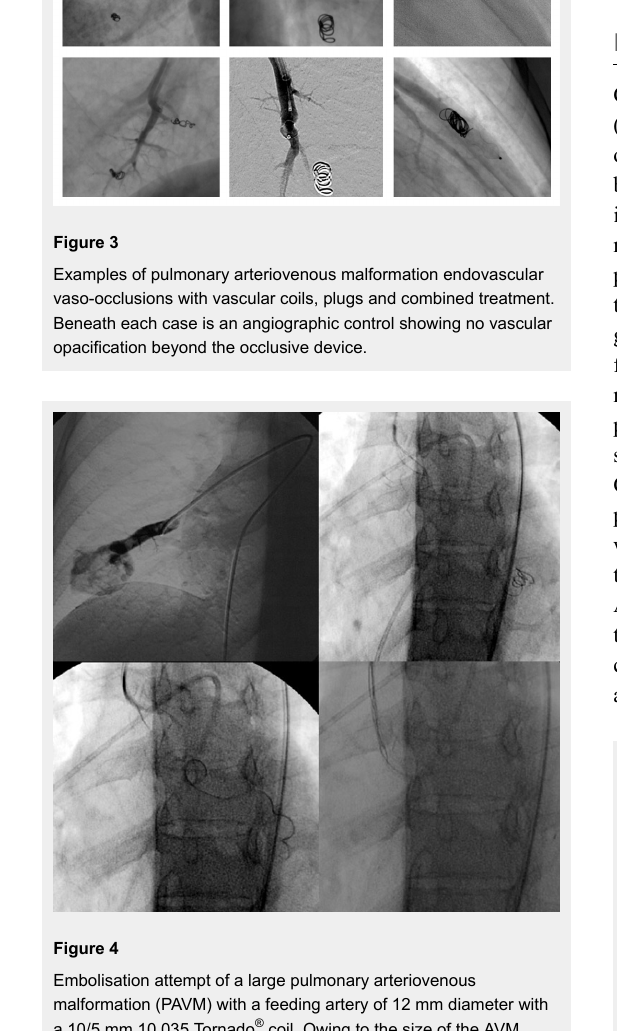
Examples of Hyperion™ vascular plugs (a, b) and a Tornado ® Embolization Coil